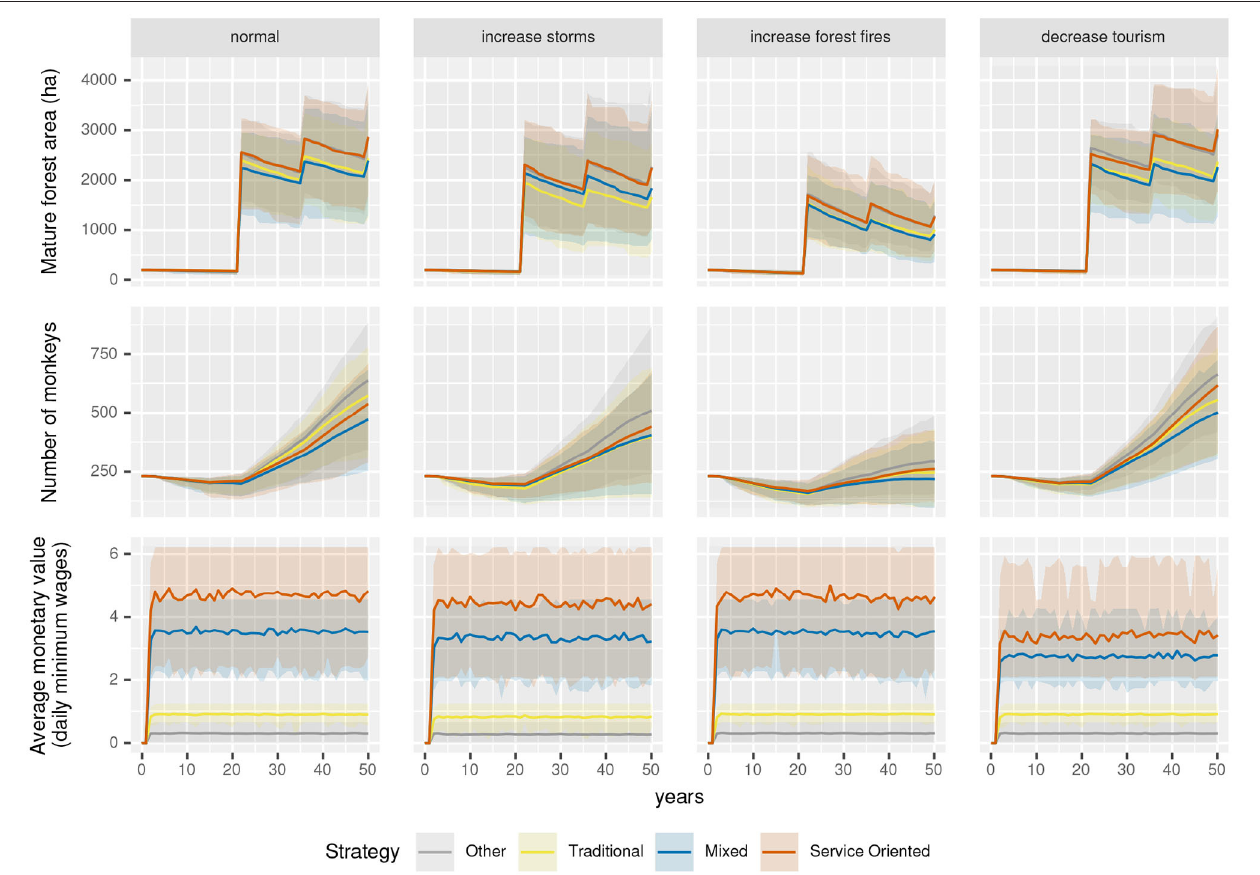
FIGURE 7 | Model results for different strategies under different scenarios. Each column of graphs represents a different scenario and each row a different output variable. The four scenarios shown are: a scenario with normal level of all disturbances, a scenario with an increase in the storms and hurricane occurrence probability, a scenario with an increase in the probability of occurrence of forest fires and a scenario with a decrease in the probability of the flow of tourists. First row: Mature forest area in ha (forest with successional age > 50 years). Second row: total number of monkeys. Third row: average monetary value of activities done by the households in daily minimum wages. Lines represent the mean and upper and lower shadows represent 5th and 95th quartiles, respectively, for different strategies (in colors), each ran over a 50 years period and for 30 simulation realizations.